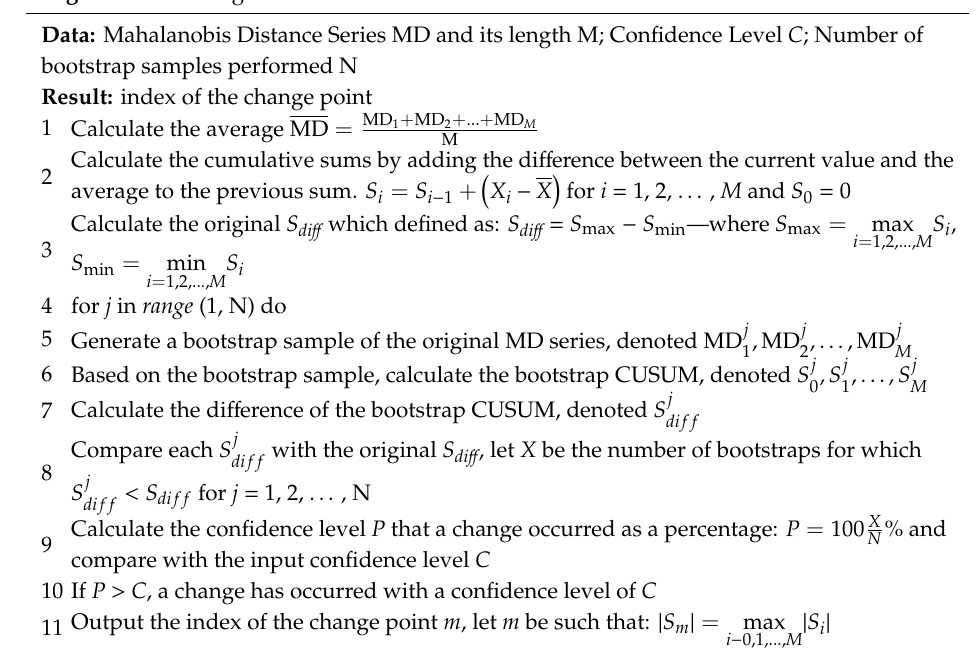
Algorithm 1: Change-Point